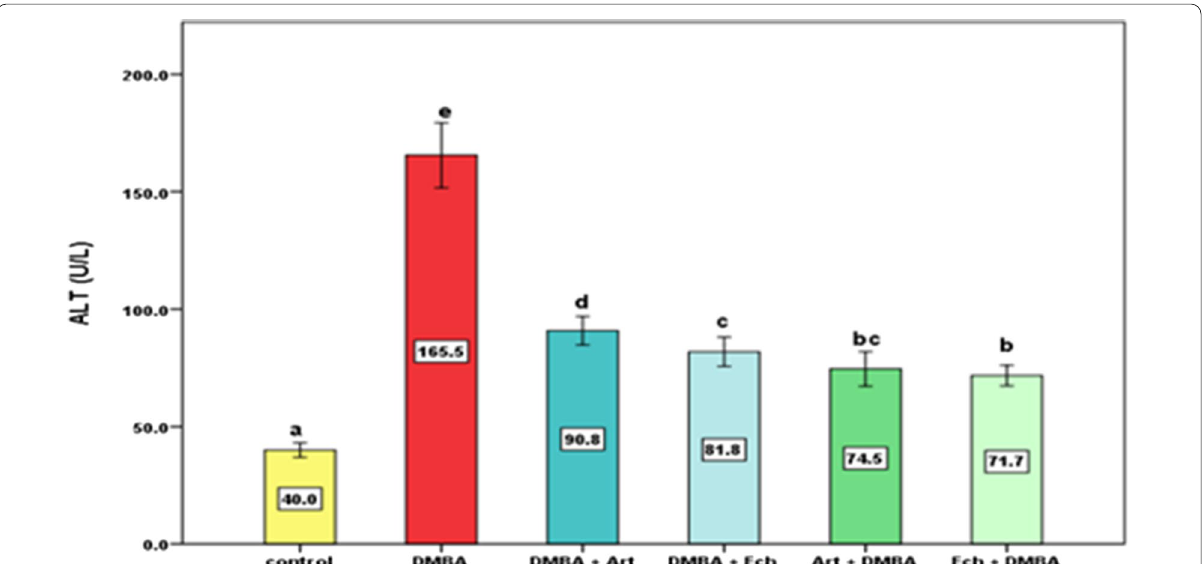
Fig. 1 Effect of treatment or protection with Artemisia or Echinacea on serum alanine aminotransferase (ALT) activity (U ∕ L) in DMBA‑administered rats of all experimental groups. Values with different letters above columns are considered significantly different ( P ˂ 0.05). Values with same letters above columns are considered non‑significantly different ( P ˂ 0.05)